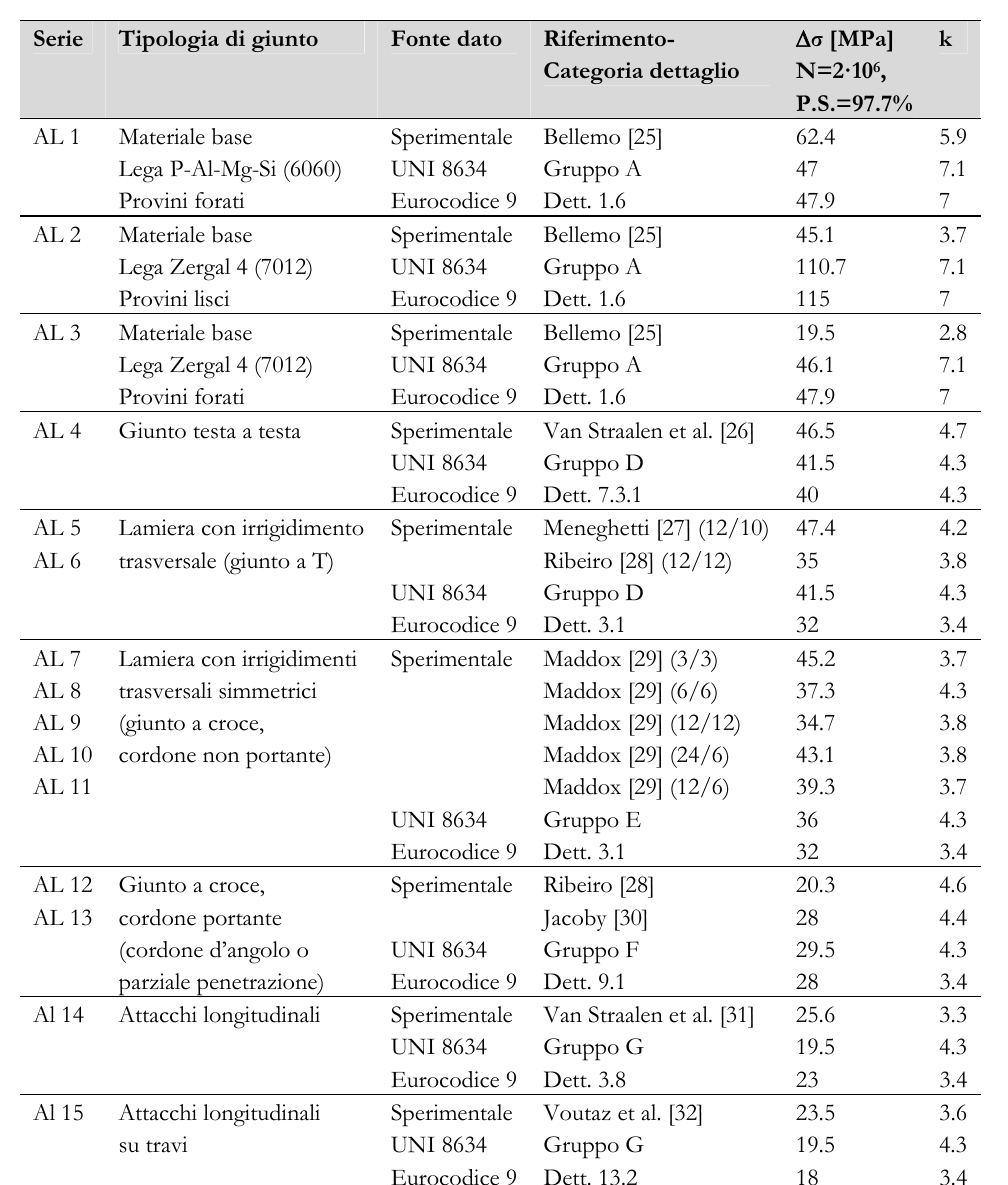
Tabella4: Serie sperimentali analizzate: corrispondenza con le normative e confronto dei valori di resistenza. Giunti testa a